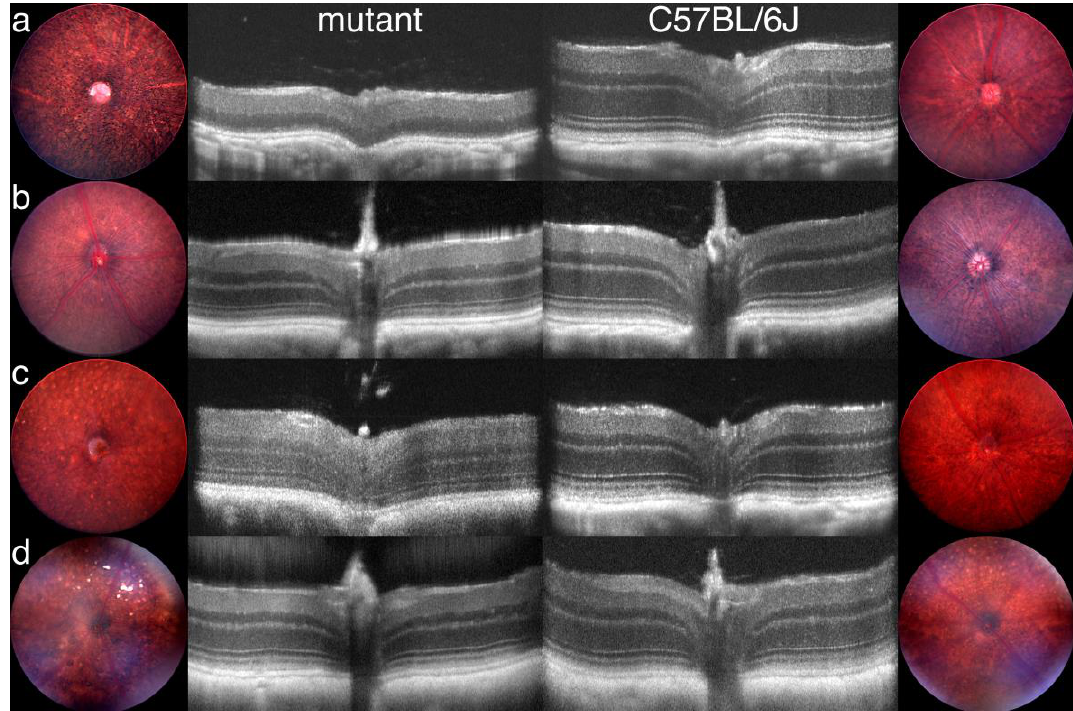
Figure 5. Characterization of mouse models from the Translational Vision Research Models (TVRM) program at JAX. A fundus image (circular panels) and corresponding OCT B-scan are shown for homozygous ( a ) Rpgrip1 nmf247 , at one month of age; ( b ) Nmnat1 tvrm113 , at two months; ( c ) Alms1 Gt(XH152)Byg , at one year; and ( d ) Ctnna1 Tvrm5 , at two years. Age-matched OCT and fundus images for C57BL6/J control mice are shown to the right of the mutant images. PR cell loss is indicated by a decreased ONL thickness. Fundus images were acquired using a Micron III or IV retinal camera. The vertical dimension of OCT images was doubled to emphasize changes in retinal layer thicknesses.